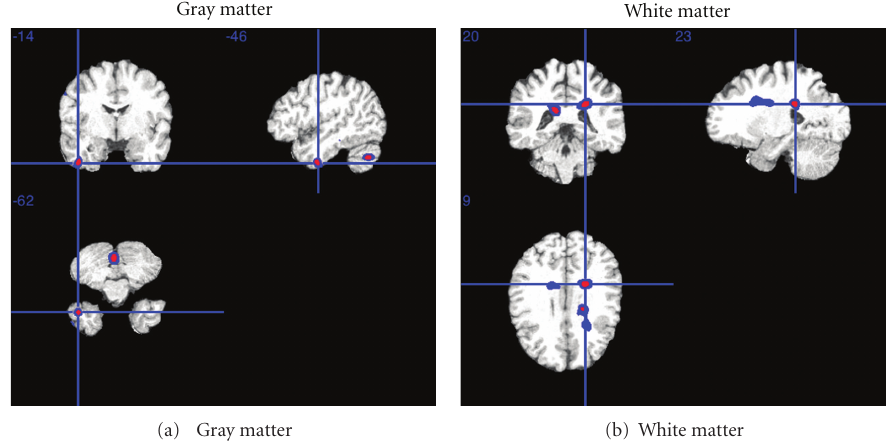
Figure 1: The highlighted zones indicate regions in which higher social activity was associated with larger brain volumes from voxel-based morphometry analysis. Only clusters of 100+ voxels shown. See Table 4 for cluster-specific